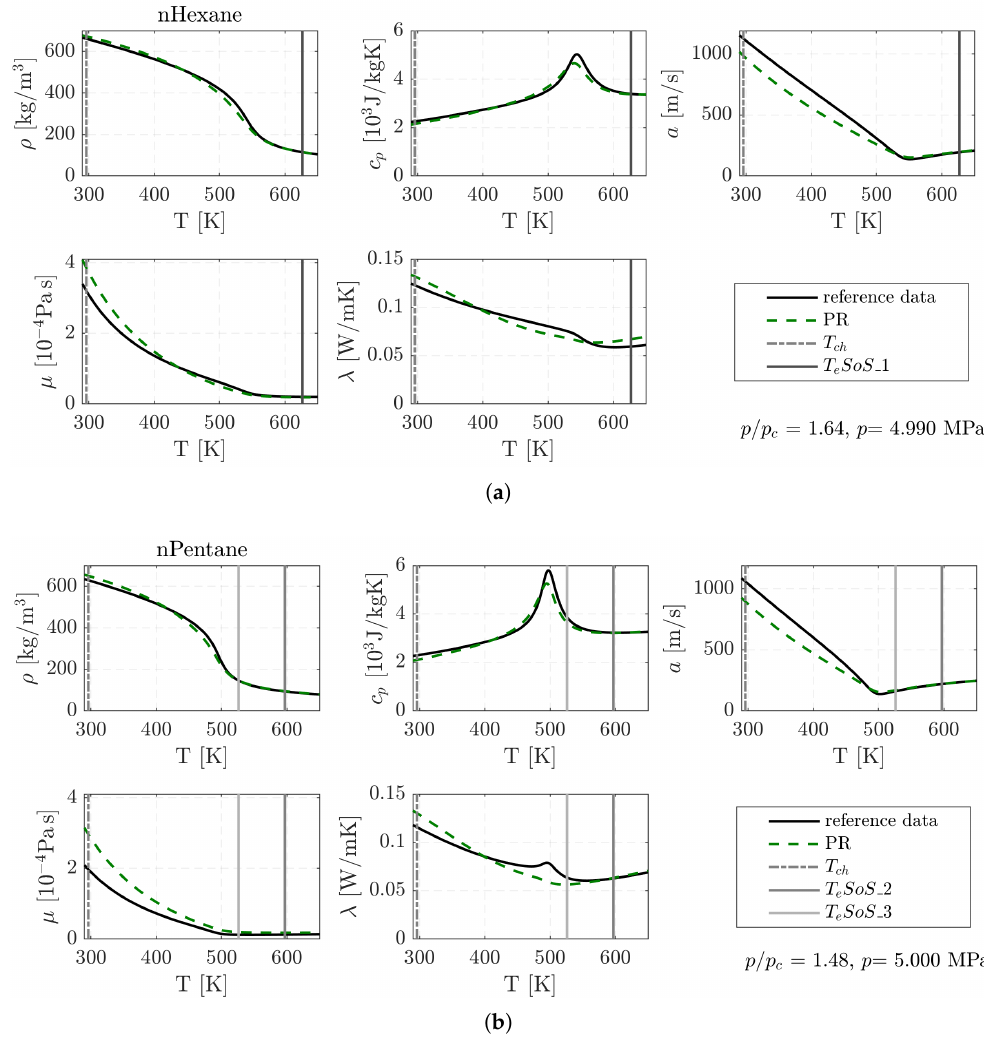
Figure 3. Thermodynamic modeling using the Peng–Robinson EoS for nHexane in ( a ) and for nPentane in ( b ). Reference data [73] is included for comparison. Figures are generated using realtpl